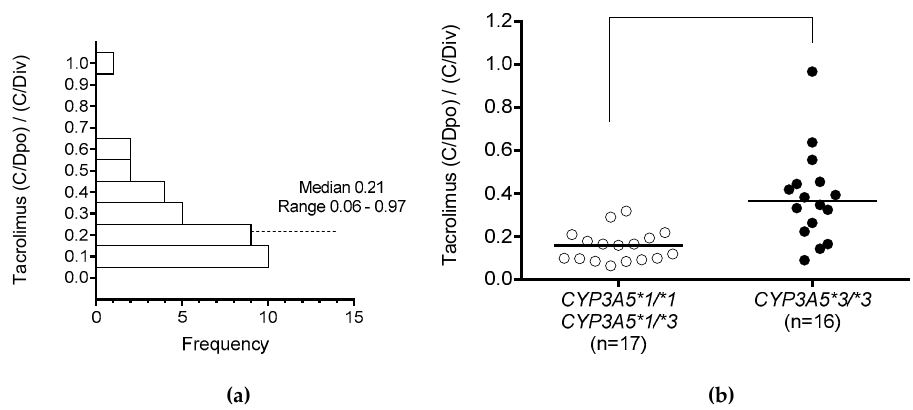
Figure 2. Histogram of (C/Dpo)/(C/Div) of tacrolimus ( a ) and of (C/Dpo)/(C/Div) of tacrolimus according to CYP3A5 genotype ( b ). The C/D ratio of tacrolimus from just before the change from continuous intravenous infusion (C/Div) was compared with that from 4–7 days after the change to oral administration (C/Dpo). The bars show the median values. *** p < 0.001.